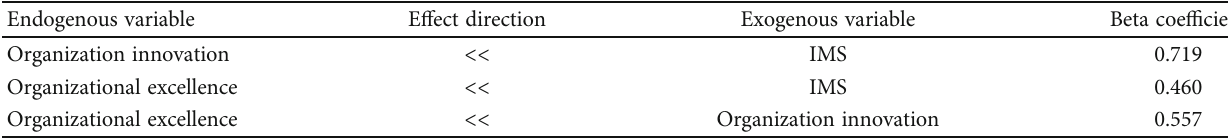
Table 11: Standardized regression weights.